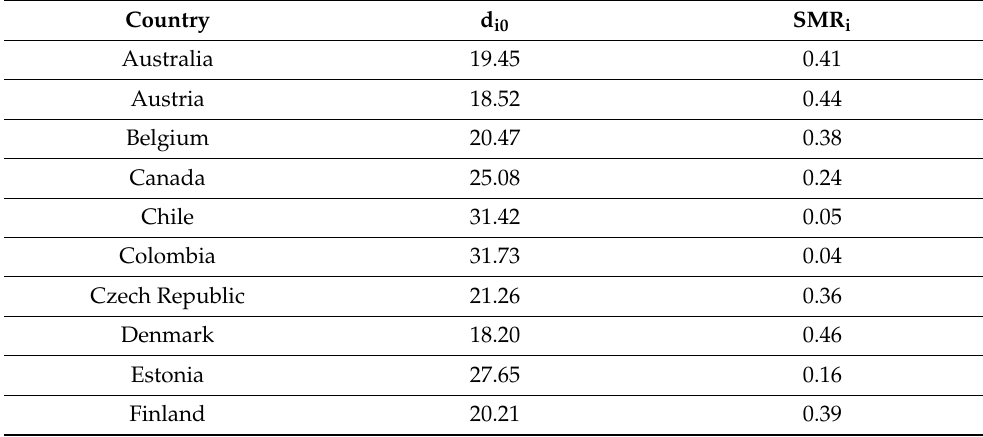
Table 5. Distance from the pattern (d i0 ) and synthetic measure of development (SMR i